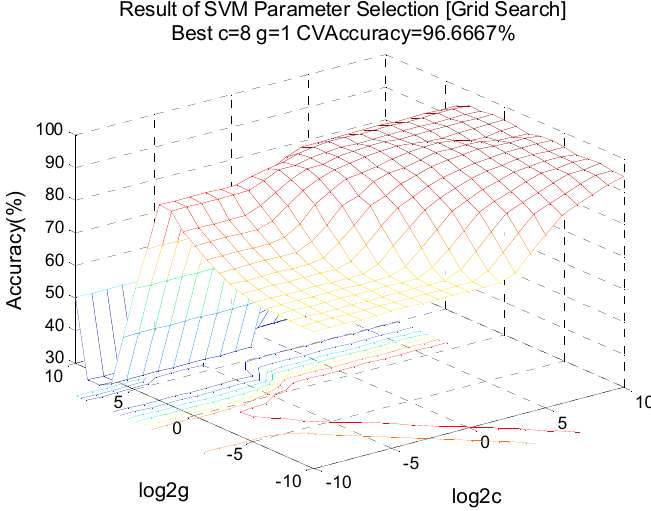
Figure 12. Optimized SVM using grid search.